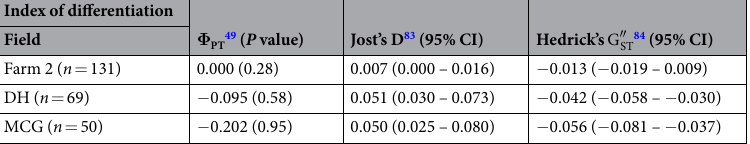
Table 2. Indices of differentiation for C. beticola populations collected from table beet and swiss chard growing in sympatry in New York (Farm 2) and Hawaii (DH and MCG). P values and confidence intervals were estimated after 999 randomisations.